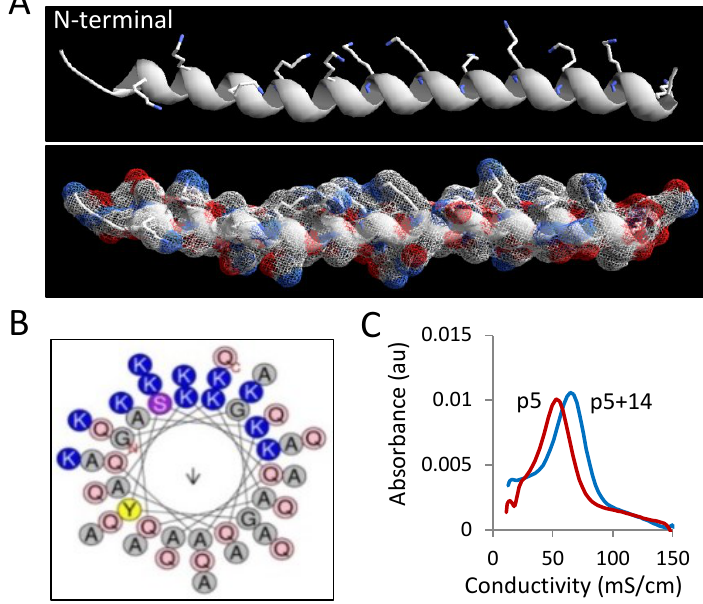
Figure 1. Peptide p5+14 is predicted to be α-helical and binds immobilized heparin. ( A ) The secondary structure of peptide p5+14 was predicted to be α-helical using the iTASSER algorithm [41]. The lysine side chains (blue) align along one surface of the helix; ( B ) Helical wheel representation of peptide p5+14 predicts linear array of lysine residues; ( C ) Peptide p5+14 (blue) bound immobilized heparin with greater affinity that the truncated peptide p5 (+8 net charge;